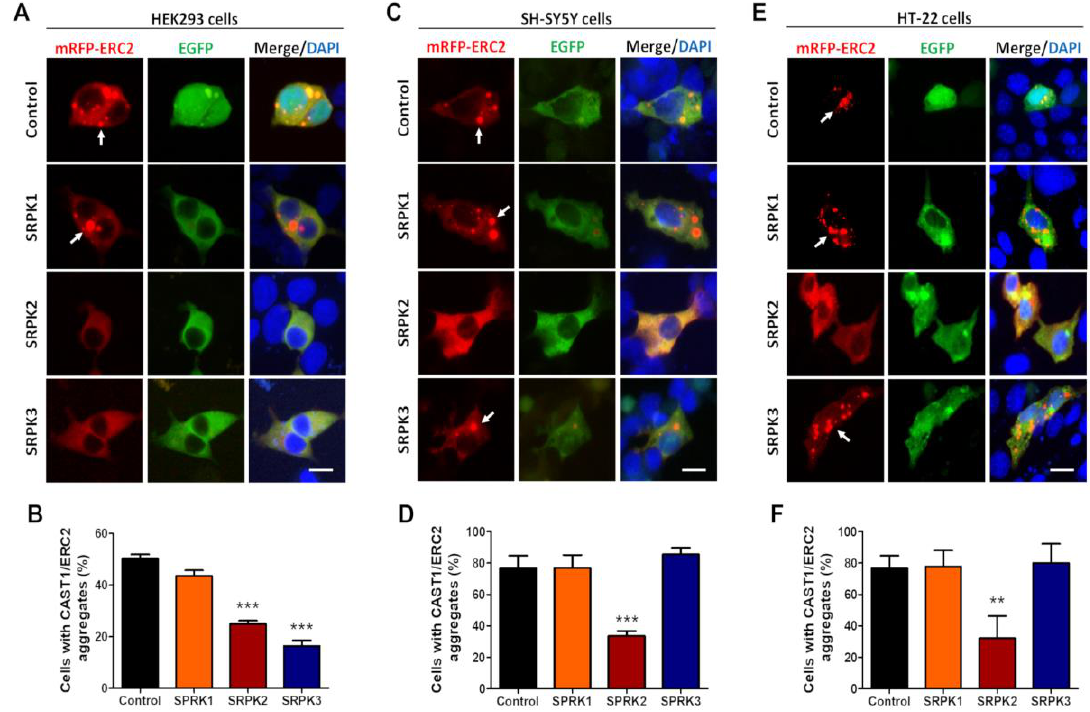
Figure 4. SRPK2 disrupts the aggregation of CAST1 / ERC2 in heterologous cells. ( A ) HEK293T, ( C ) SH-SY5Y and ( E ) HT-22 cells were co-transfected with mRFP-CAST1 / ERC2 and EGFP (control) or EGFP-SRPK1, -2 and -3 plasmids. Graphs show the quantification of the percentage of cells containing mRFP-CAST1 / ERC2 aggregates in ( B ) HEK293T, ( D ) SH-SY5Y and ( F ) HT-22 cells. For mRFP-CAST1 / ERC2 and EGFP-SRPKs the plasmid amount used for transfection of a 24-well plate was 0.5 µ g / well for HEK293 cells, and 1.0 µ g / well for SH-SY5Y and HT-22 cells. Data are presented as mean ± SEM, and statistical analysis was done by ANOVA and Bonferroni’s post-hoc test; n = 100 cells (three independent experiments). ** p < 0.01; *** p < 0.001. Scale bar: 15 µ m. Similar to HEK293T cells, CAST1 / ERC2 showed a punctate pattern in nearly 80% of the transfected fraction of cells with CAST1 / ERC2 aggregates in both neuronal cell lines (SH-SY5Y, 33.65% ±